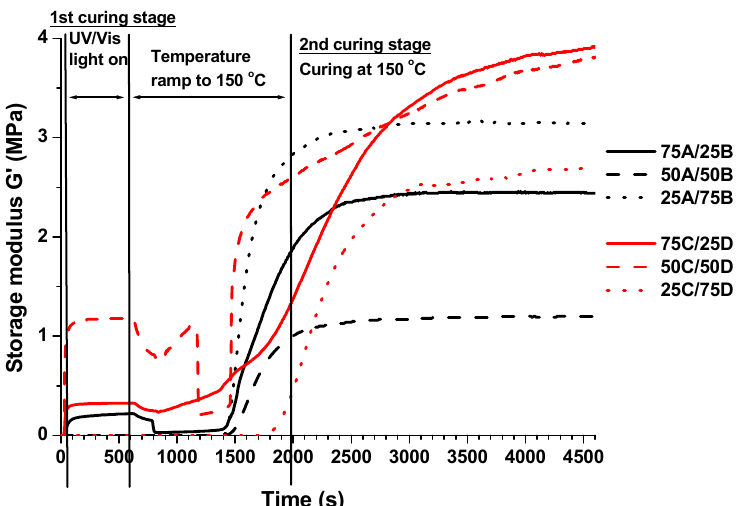
Figure 3. Storage modulus versus curing time of dual cured vegetable oil-based resins.